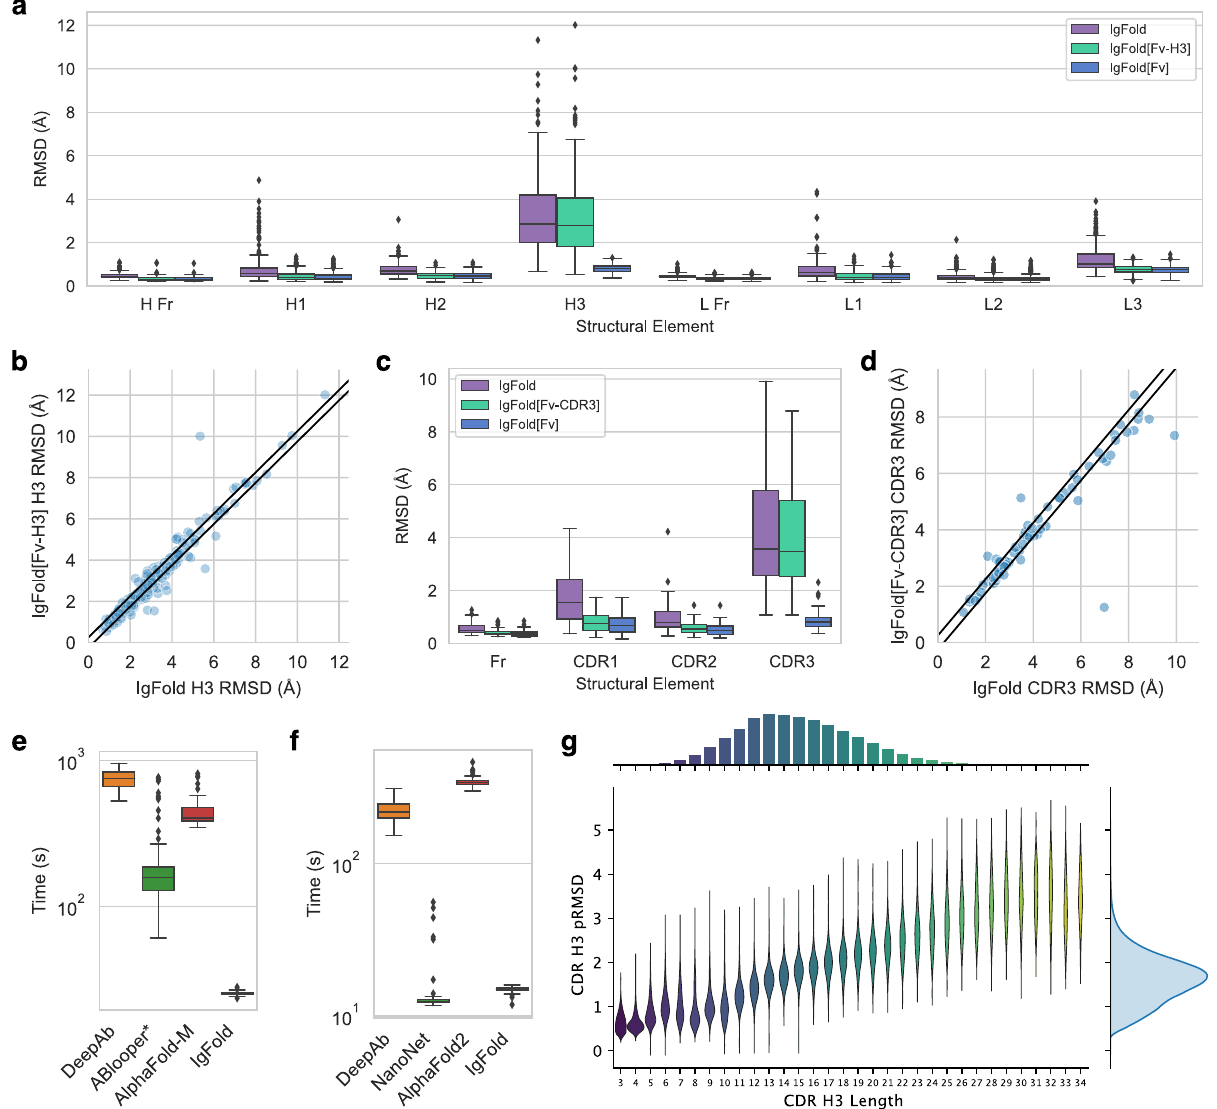
Fig.4|UtilityofIgFoldforantibodystructureprediction. Boxplotshavecenter atmedian, bounds indicating interquartilerange (IQR), whisker length of 1.5×IQR, andpoitnsoutsideof1.5×IQRrangeshownasoutliers.Sourcedataareprovidedas a Source Data fi le. a Paired antibody structure prediction benchmark results ( n =197 structure predictions) for IgFold without templates, IgFold given the F V structure without the CDRH3 loop (IgFold[Fv-H3]), and IgFold given the complete Fv structure (IgFold[Fv]). b Per-target comparison of CDR H3 loop structure pre- diction for IgFold and IgFold[Fv-H3], with each point representing the RMSD H3 for both methods on a single benchmark target. c Nanobody structure prediction benchmark results ( n =71 structure predictions) for IgFold without templates, IgFold given the F V structurewithout the CDR3 loop (IgFold[Fv-CDR3]), and IgFold